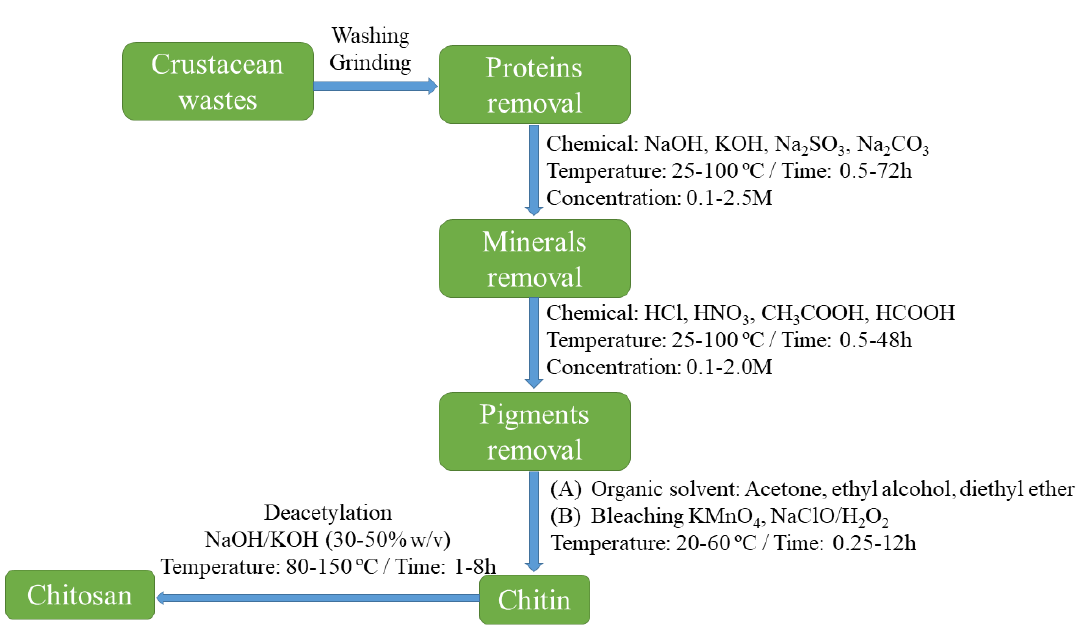
Figure 2. Purification processes of crustacean wastes.